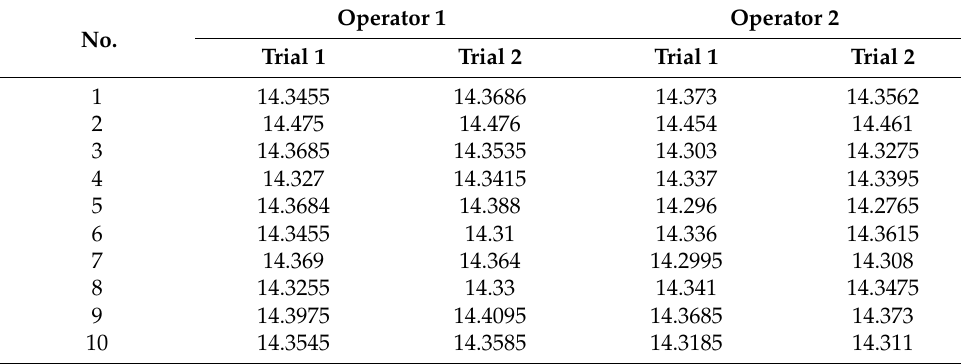
Table 5. Measurement system variation test data.